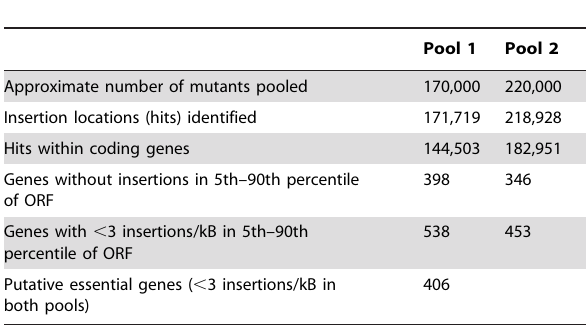
Table 1. Identification of essential genes using saturation transposon mutagenesis and